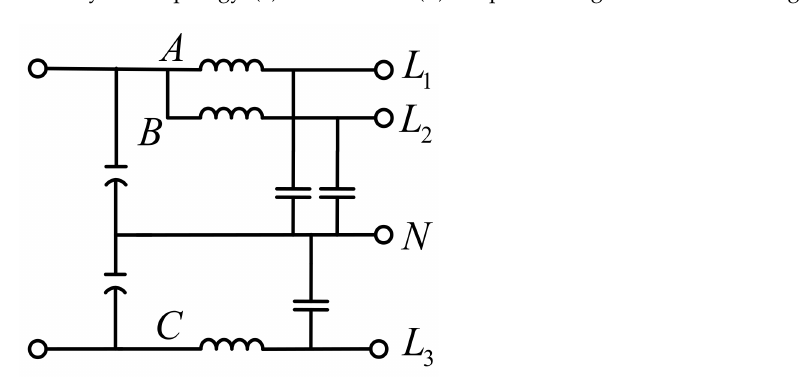
Figure 3. Simplified diagram of one working state of 3-phase 4-wire system